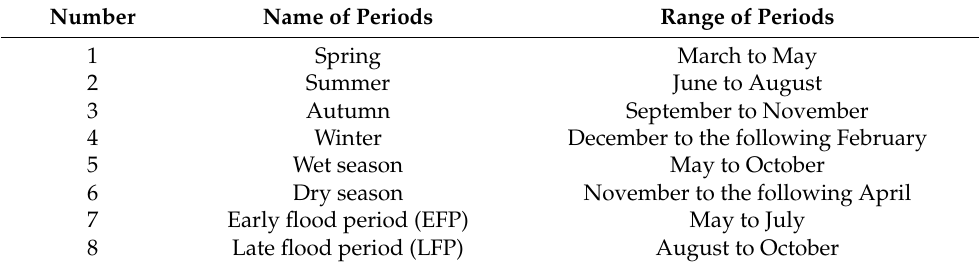
Table 1. The eight sub-annual periods used in this